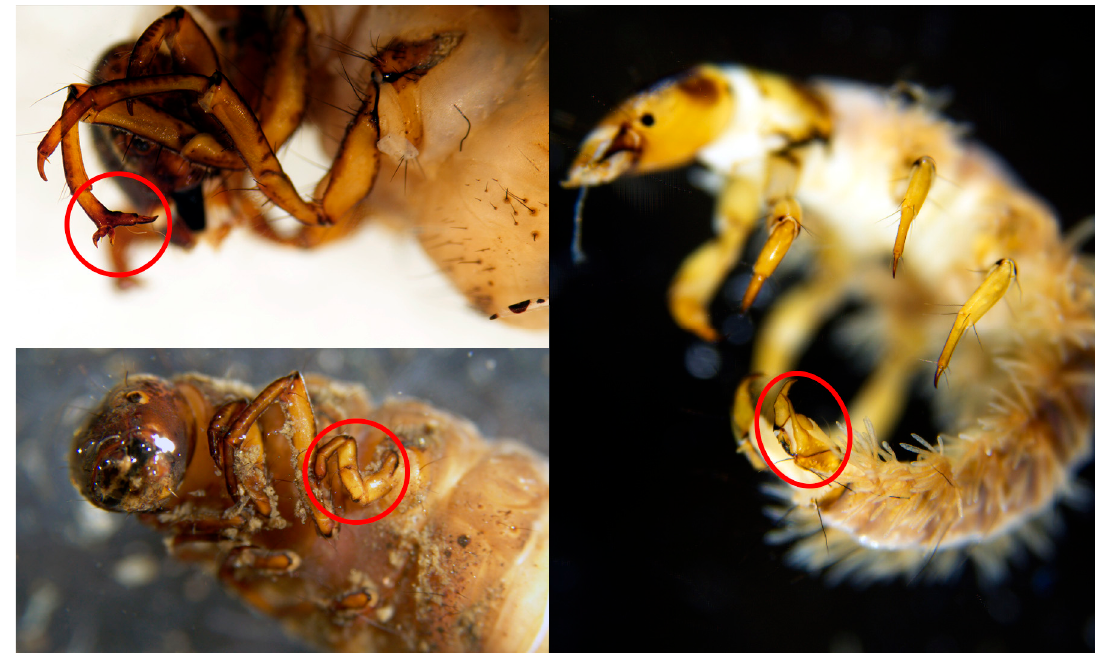
Figure 6. Malformed limbs of Halesus cf. tesselatus (two pictures on the left) and Rhyacophila cf. aurata (right side) sampled at Sites 3 and 4.